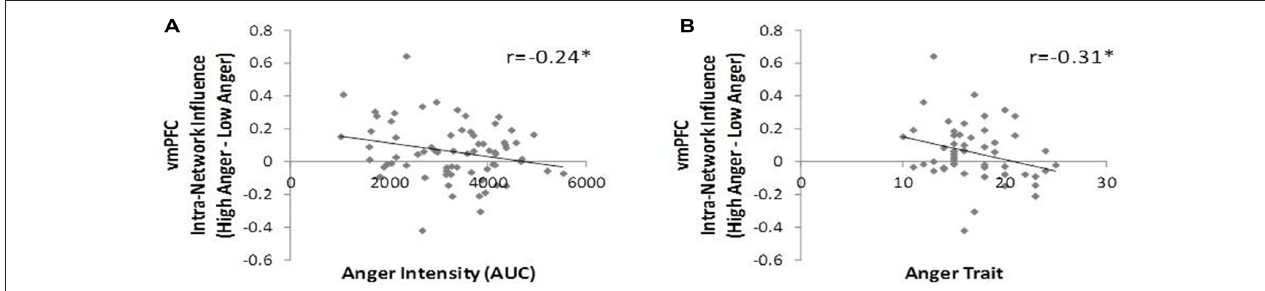
FIGURE 6 | D EP NA features association to behavior. The vmPFC intra-network influence was found in negative correlation with the anger intensity measure during the movie excerpt (A) and with trait-anger measure (B) . Therefore, the more the subject reported higher anger intensity and the more they tend to get angry in general, the lower was the vmPFC influence on the rest of the regulation network regions. ∗ p < 0.05, FDR